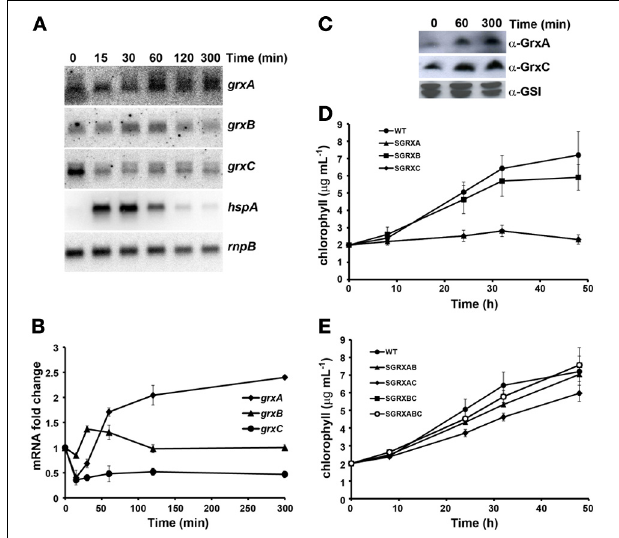
FIGURE 4 | Effect of heat shock on glutaredoxin gene expression and growth. (A) Northern blot analysis of grxA , grxB , grxC, and hspA expression in response to heat shock. Total RNA was isolated from exponentially growing WT cells at the indicated times after the shift from 30 to 42 ◦ C. The filter was hybridized with grxA , grxB , grxC, and hspA probes and subsequently stripped and re-hybridized with an rnpB probe as a control. (B) Quantification of relative mRNA levels of grxA , grxB, and grxC in to response to heat shock. Radioactive signals were quantified and normalized to the rnpB signal. Plots of relative mRNA levels vs. time were drawn; data represent average of 3 independent experiments and error bars represent SE. grxA ( (cid:4) ), grxB ( (cid:2) ), and grxC ( • ). (C) Western blot analysis of GrxA and GrxC levels in response to heat shock. WT cells